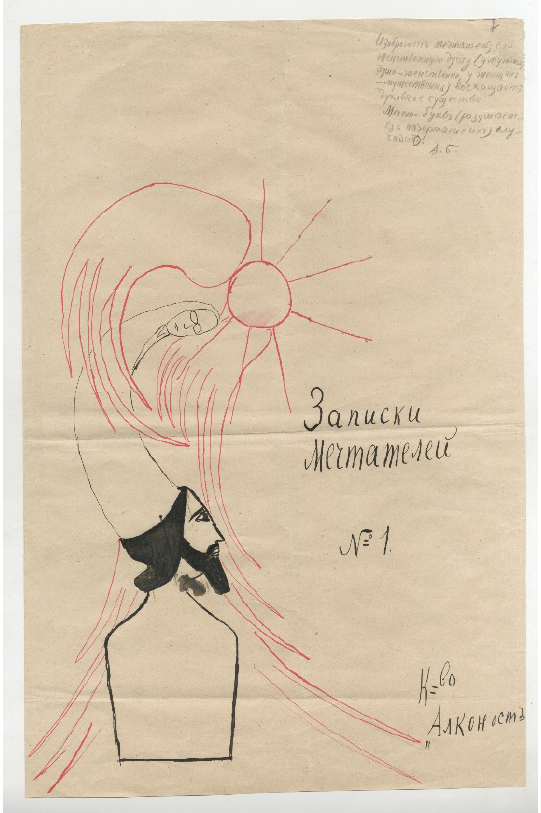
Figure 7. Andrei Bely. Sketch for the journal cover Dreamers’ Notes. 1918–1919. RGALI.